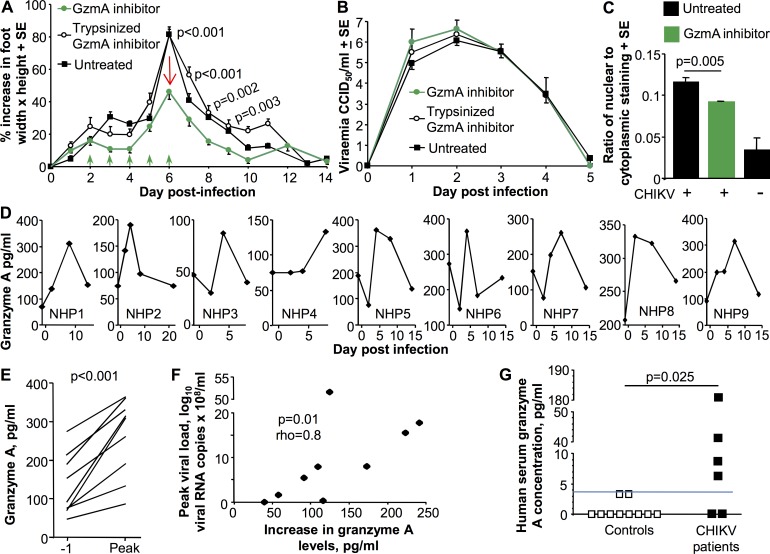
Granzyme A inhibitor and granzyme levels in CHIKV infected primates.(A) On days 2 to 6 post infection with CHIKV, C57BL/6 mice were treated i.v. with 10 μg of the granzyme inhibitor, Serpinb6b, or Trypsinized (inactivated) GzmA inhibitor (green arrows) or were left untreated. The data represents results from 2 independent experiments: GzmA inhibitor (n = 14 feet, 7 mice); Trypsinized GzmA inhibitor (n = 6 feet, 3 mice); untreated mice (n = 30 feet, 15 mice). Statistics by t test; p values provided for comparisons between granzyme A inhibitor and Trypsinized granzyme A inhibitor and are only provided where comparisons between granzyme A inhibitor and untreated mice were also significant. (B) Viraemia for the same mice as shown in A. (C) Aperio Positive Pixel Count determination of the ratio of blue (nuclear) to red (cytoplasmic) pixels in H&E stained whole foot sections day 6 post infection (as in Fig 5B). (n = 6 feet from 3 mice per group, 3 sections per foot; statistics by Kolmogorov Smirnov test). (D) Granzyme A levels in plasma samples from CHIKV-infected non-human primates (NHPs) measured using an ELISA kit. Data for 9 NHPs is shown; all NHPs had samples collected day -1, one day prior to CHIKV infection. (E) Granzyme A levels on day -1 and peak granzyme A levels plotted for the 9 NHPs. Statistics by paired t test. (F) Correlation between peak viral load (S9D Fig) and the increase in granzyme A levels from day -1 to peak (i.e. peak levels minus day -1 levels). Statistics by Spearman correlation. (G) Serum granzyme A levels in healthy controls and IgM positive symptomatic CHIKV patients. Granzyme A levels were determined using cytokine bead array and FACs. The limit of detection is deemed to be 3.7 pg/ml. Statistics by Kruskal-Wallis test.